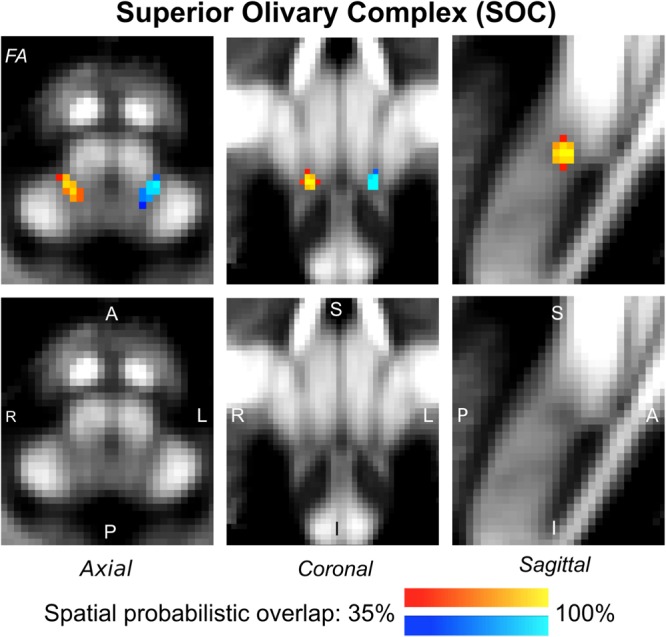
Probabilistic atlas label in MNI space of the SOC (left: blue-to-cyan; right: red-to-yellow). The SOC was hypointense in diffusion FA MRI; its label is overlaid on the group average FA map. Very good spatial (i.e., up to 100%) agreement of labels across subjects was observed indicating the feasibility of delineating the probabilistic label of this nucleus, which is a brainstem structure involved in auditory and auditory-motor functions.